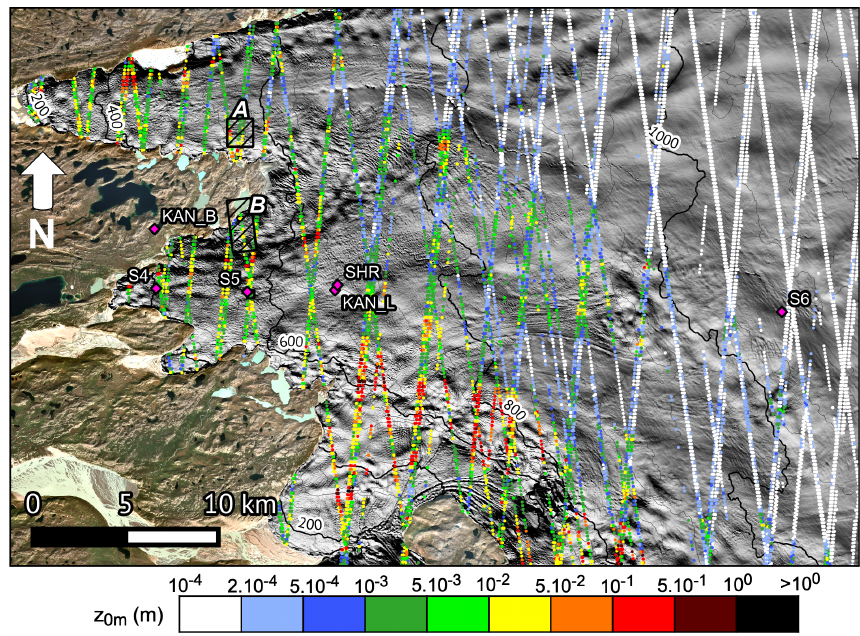
Figure 9. Estimated aerodynamic roughness length ( z 0m ), without accounting for the residual photon backscatter, from ICESat-2 between 16 October 2018 and 6 September 2020 in the lower part of the K-transect, West Greenland. The locations of the automatic weather stations are given by the pink diamonds. The black boxes A and B delineate the areas mapped by UAV photogrammetry. A hillshade of ArcticDEM (Porter et al., 2018) is shown as background over the ice